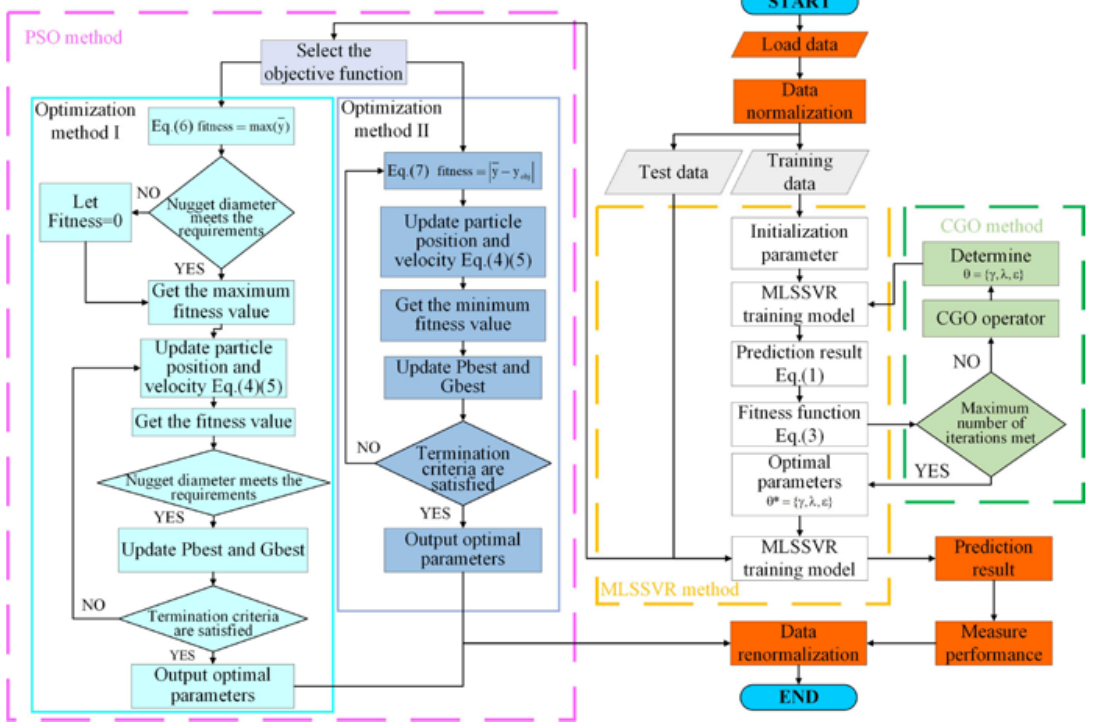
Figure 2. Flow chart of the PSO optimisation process parameters.